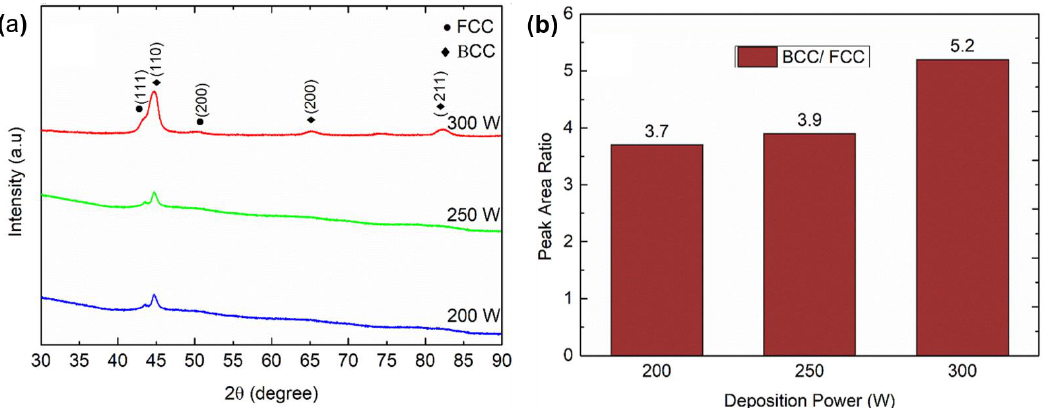
Figure 7. Crystal structure of film under different RF powers. ( a ) XRD plots, ( b ) peak area ratios of BCC and FCC contents of AlCoCrCu 0.5 FeNi films grown at three different RF powers [ 59 ] . Copyright 2020 Elsevier.